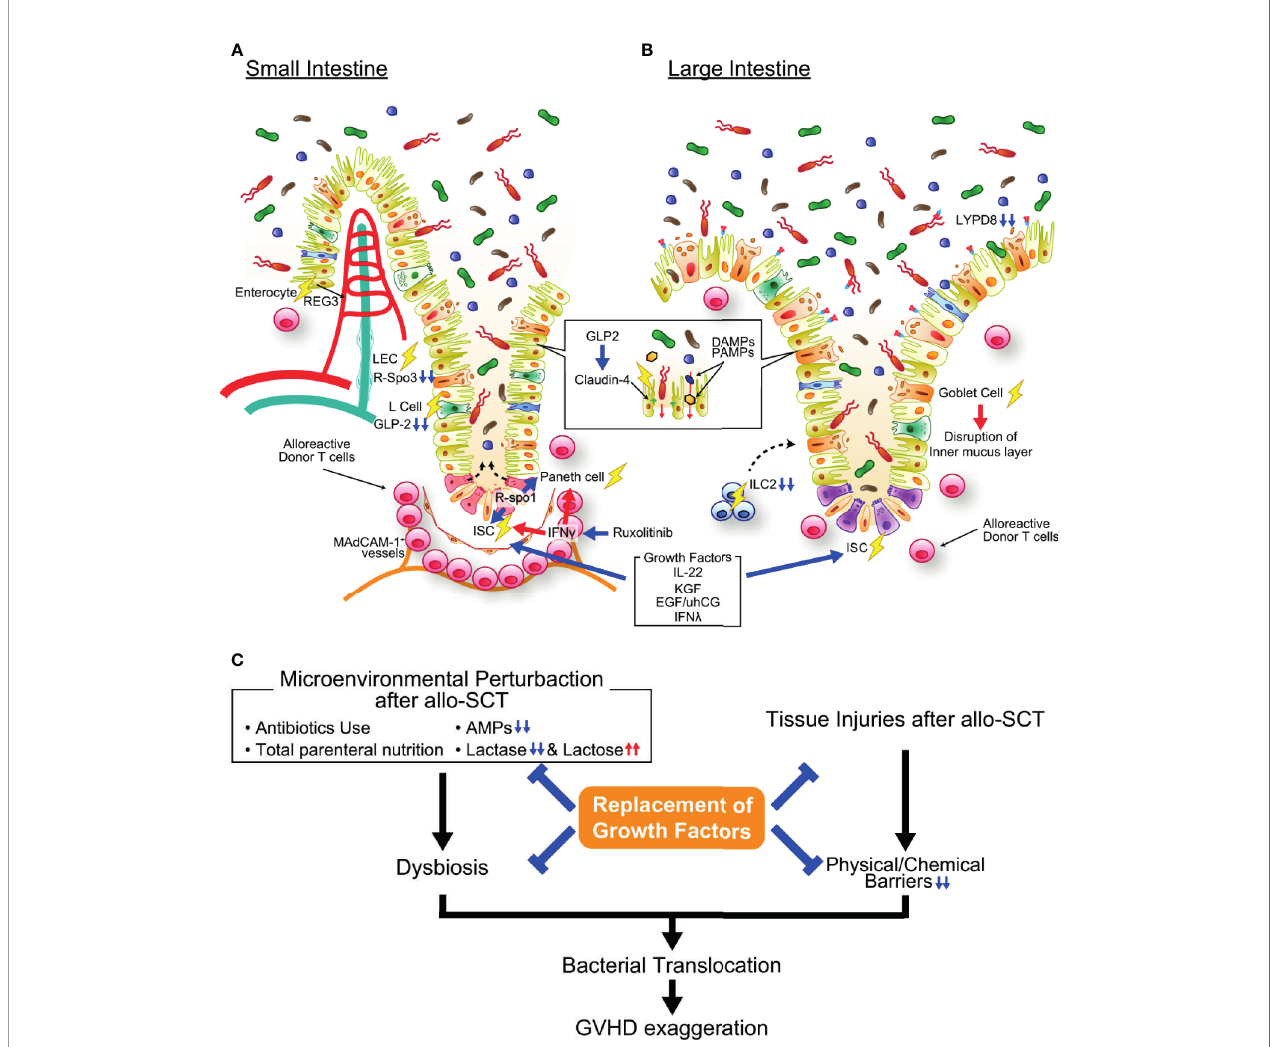
FIGURE 2 | Pathophysiology of gastrointestinal graft-versus-host disease (GVHD). (A) In the small intestine, activated alloreactive donor T cells (pink round cells in fi gure) migrate to the crypt base region early after allogeneic transplantation in a MAdCAM-1-dependent manner and damage ISCs, resulting in impairment of mature intestinal epithelial cell regeneration. Paneth cell injury causes the reduction of AMP production and loss of function as an ISC niche. IFN- g plays an important role in both ISC and Paneth cell injury in GVHD, and ruxolitinib protects ISCs and Paneth cells against GVHD. Moreover, growth factors of ISCs such as R-Spondin 3, IL-22, and GLP-2 are reduced in the intestine due to GVHD-induced reduction of LECs, ILC3s, and L cells. The expression of tight junction molecules such as claudin-4 are also reduced in GVHD, resulting in disruption of intestinal epithelial barrier function. (B) In the large intestine, goblet cell injury in GVHD results in disruption of the mucus layers bleaching both chemical and mechanical barrier functions of the intestinal mucosa. ILC2s, producer of goblet cell growth factors, are profoundly depleted by conditioning radiotherapy or chemotherapy, likely inhibiting regeneration of goblet cells. (C) Microenvironmental perturbation after allo-SCT induced by administration of antibiotics and/or total parenteral nutrition, reduction of AMP production, and lactose malabsorption leads to intestinal dysbiosis, frequently accompanying Enterococcus domination. Dysbiosis and disruption of barrier function of the intestinal mucosa enhance bacterial translocation, further exaggerating GVHD. Replacement of growth factors for ISCs, Paneth cells, and goblet cells ameliorate GVHD. Allo-SCT, allogeneic hematopoietic stem cell transplantation; DAMP, damage-associated molecular pattern; EGF, epidermal growth factor; IFN- g , interferon- g ; KGF, keratinocyte growth factor; LYPD8, Ly6/PLAUR domain-containing protein 8; PAMP, pathogen-associated molecular pattern; REG, regenerating islet-derived protein; R-Spo1, R-spondin1; uhCG, urinary-derived human chorionic